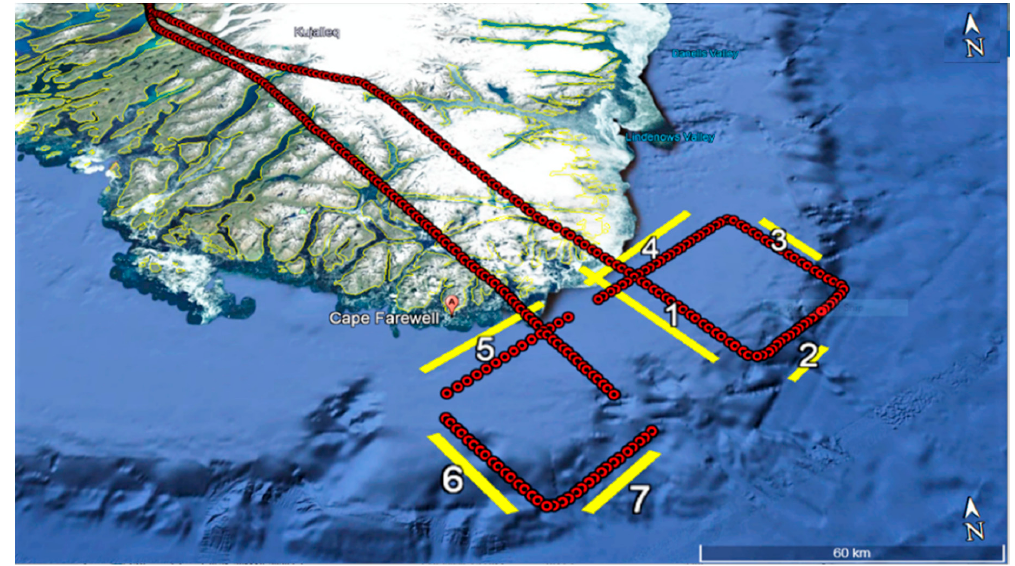
Figure 14. Flight track and DAWN profile locations (red dot) during the 31 October 2014 flight mission with identified flight legs 1–7 (Google Earth).